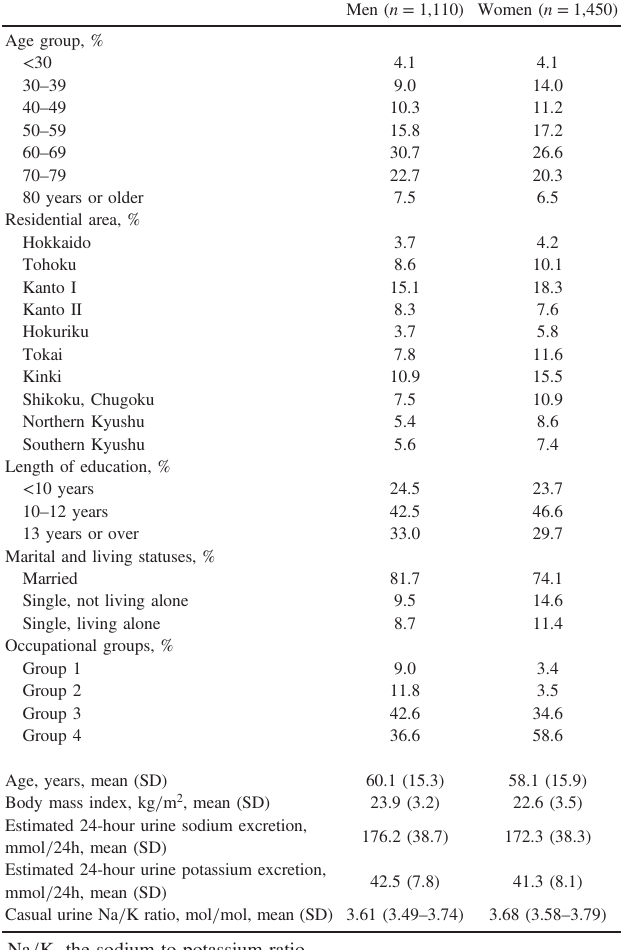
Men ( n = 1,110) Women ( n = 1,450)